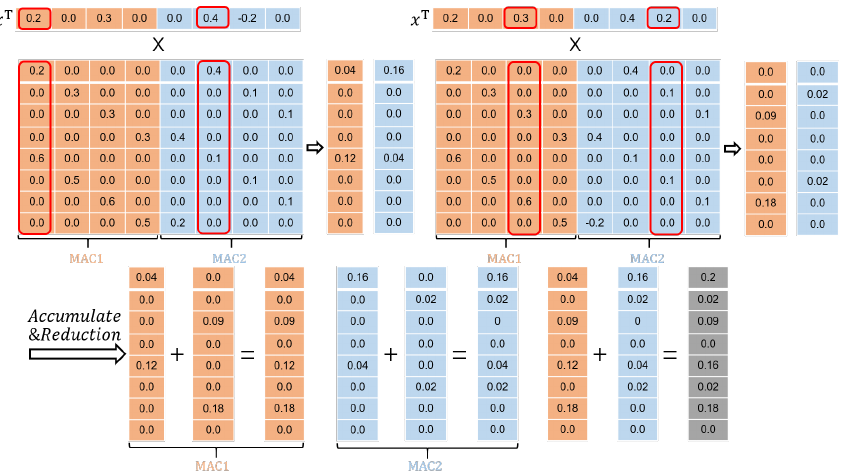
Figure 11. A column-wise processing